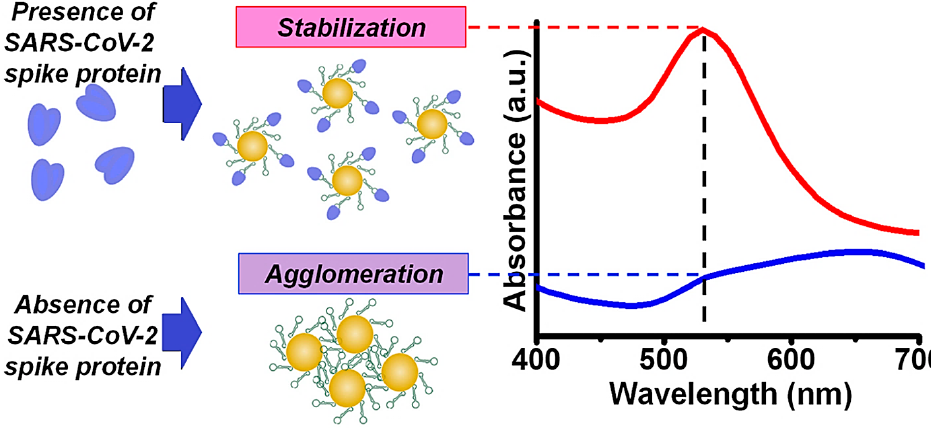
Figure 1. Specific detection of SARS-CoV-2 spike protein using aptamer-functionalized Au NPs. Adapted from Ref [41] with permission. Copyright 2021 Elsevier. Table 2. Some selected examples of functionalized Ag and Au NPs with (bio)sensing applications.